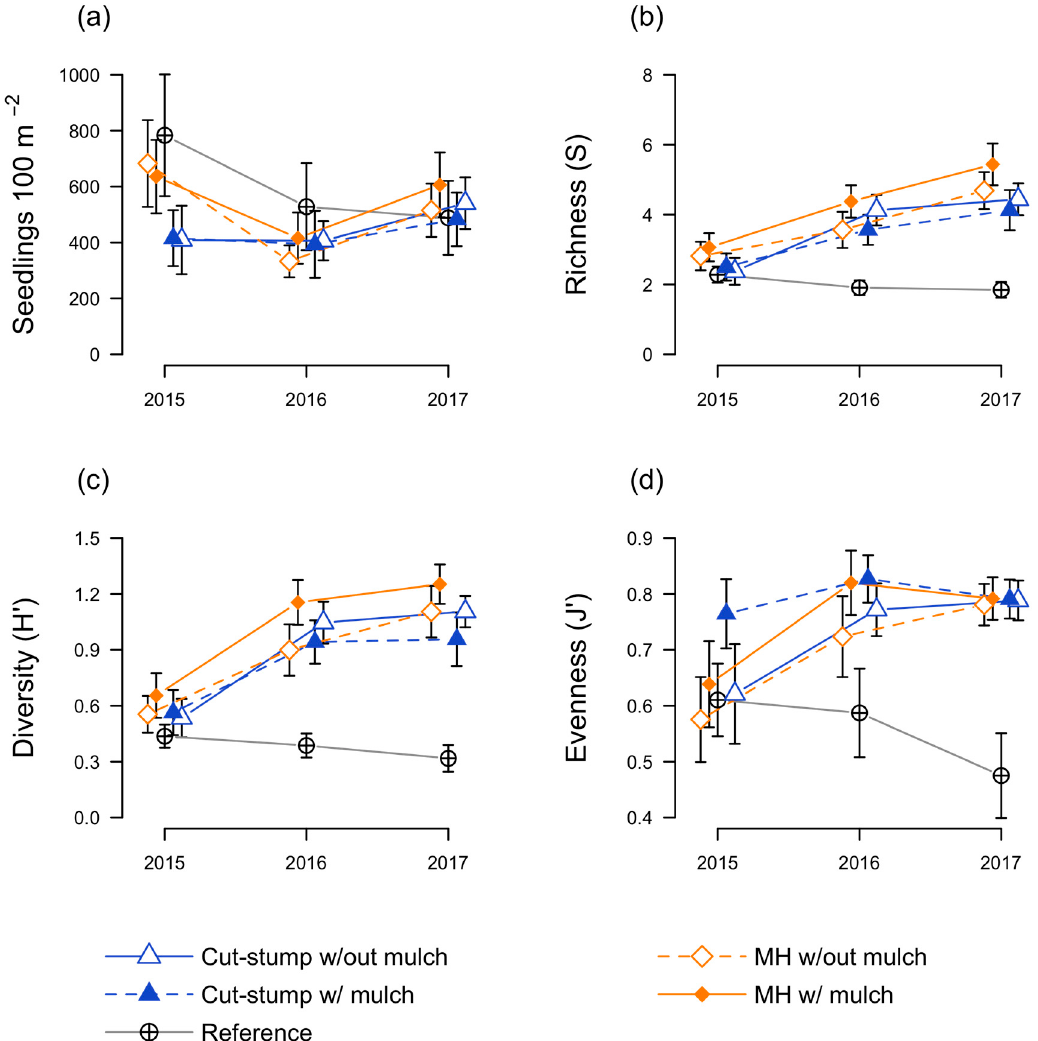
Figure 4. Densities ( a ) and diversity indices ( b – d ) of native woody species prior to invasive shrub removal (2015) and following shrub removal (2016–2017) accomplished using cut-stump or forestry mulching head (“MH”) treatments, with mulch removed/absent or added/present. Invasive shrubs were not removed in reference areas for comparison. Dashed lines indicate management techniques with mulch manipulated (added/removed) and solid lines represent operational (no mulch manipulation) management techniques. Values are means ± standard error. Data were collected from